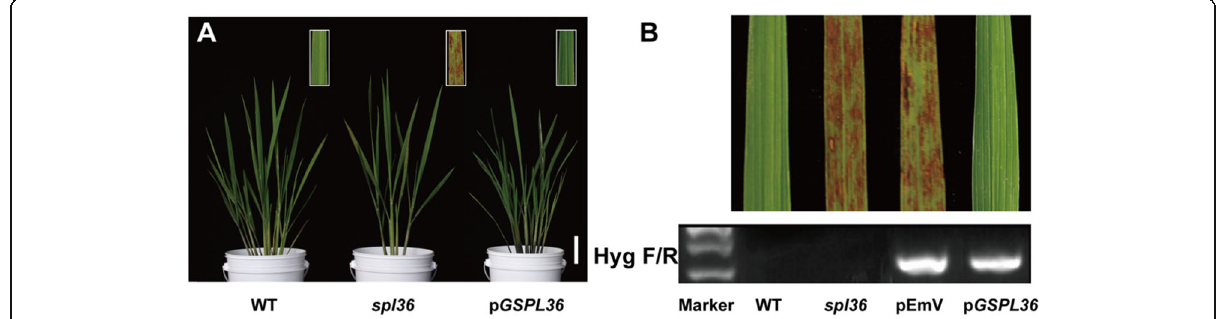
Fig. 6 Functional complementation of the spl36 mutant with LOC_Os12g08180. a The phenotype of the spl36 mutant transformed with the genomic sequence of SPL36 ( pGSPL36 ) was completely recovered to that of the wild type. The insets show enlarged views of leaf sections with lesion spots. Bar = 8 cm. b Transgenic plants were verified by the presence of the hygromycin selectable marker gene. pEmV: empty